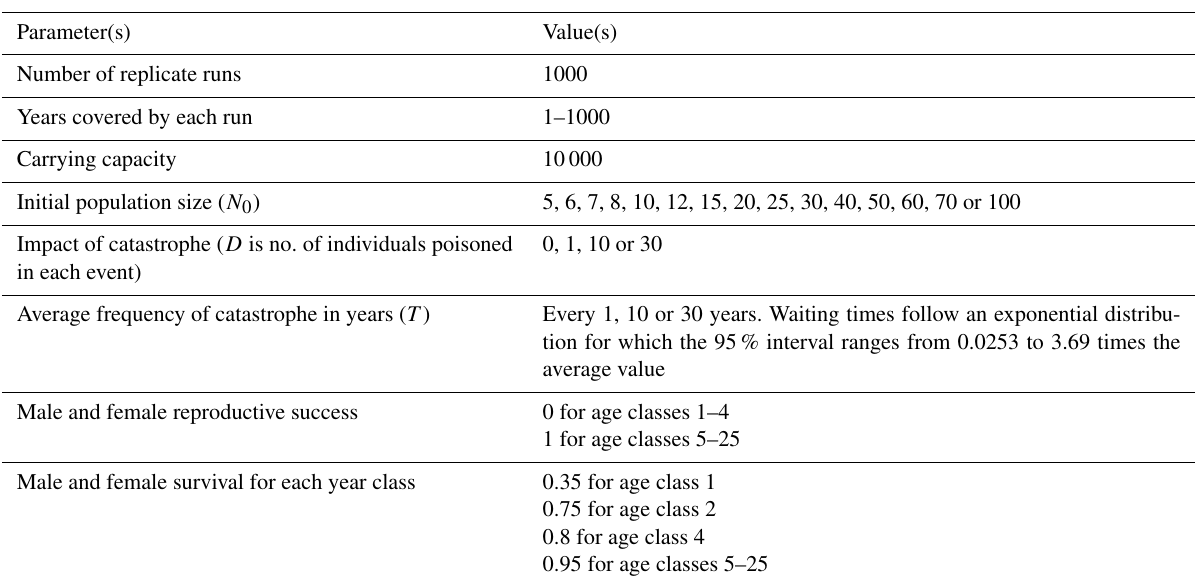
Table 1. Parameter values used in simulations in this study, including those that change according to the different model runs. Demographic parameters (e.g., reproductive success and survival rates based on data from the griffon vulture population on the island of Crete, after Xirouchakis, 2002, 2010). The parameter T is the expected time for the exponentially distributed waiting time for which the 95% interval will be (0.0253 T , 3.69 T